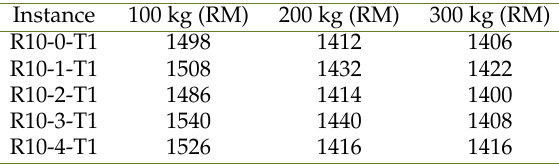
Fig. 6. A delivery tour (100 kg vehicle capacity) Table 4. Delivery routes for DC